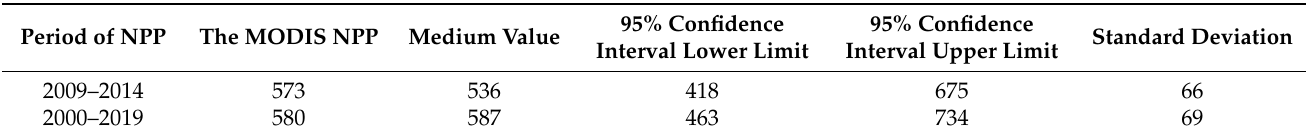
Figure 9. Uncertainty analysis probability density distribution and cumulative distribution functions for the LPJ model. Table 5. Uncertainty analysis statistics for the different periods as determined from the EFAST global sensitivity